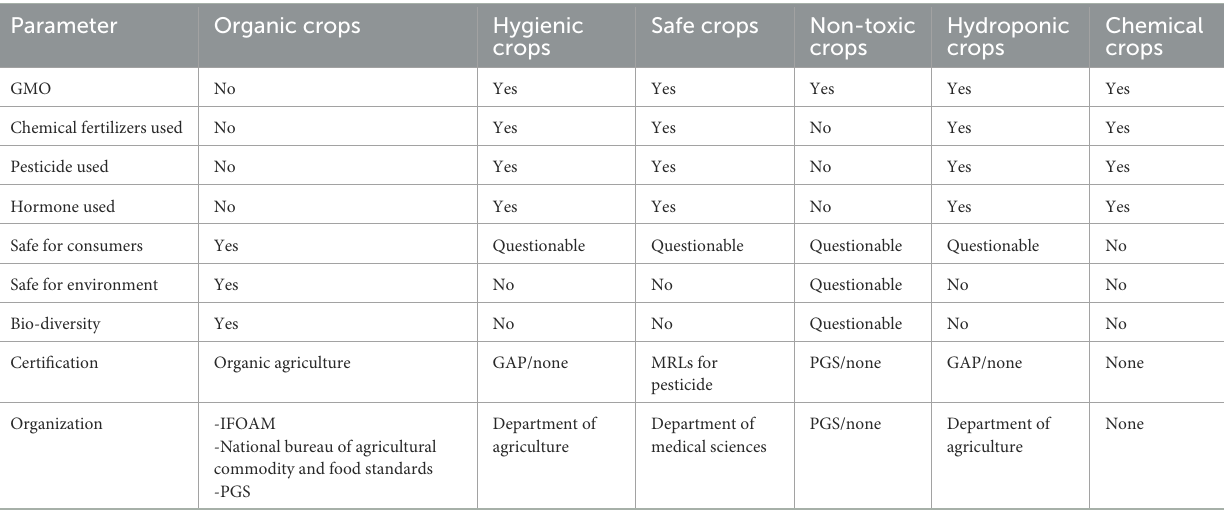
TABLE 2 Classification of agricultural crop labels in Thailand.